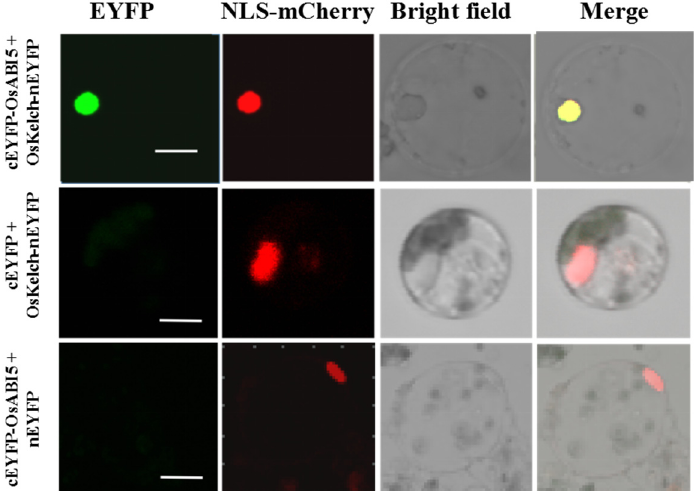
Figure 2. Bimolecular fluorescence complementation (BiFC) analysis of the interaction between OsABI5 and the Kelch repeat domain of OsKEAP1 (OsKelch) in rice protoplasts. NLS-mCherry: fluorescence of nuclear localization signal-mCherry; Merge: merge of the EYFP, NLS-mCherry, and brightfield images. Scale bars: 5 µm.